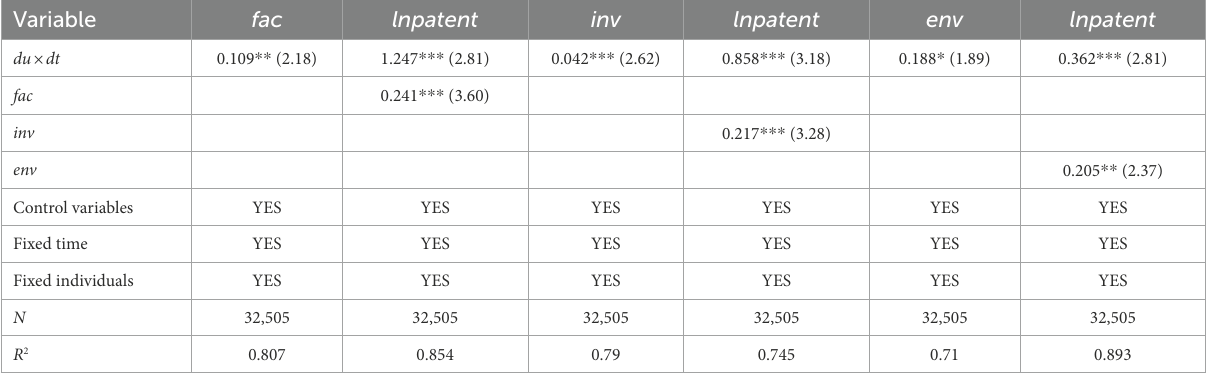
TABLE 7 Test results of the influence mechanism of mediation effect. Variable fac lnpatent inv lnpatent env lnpatent du × dt fac